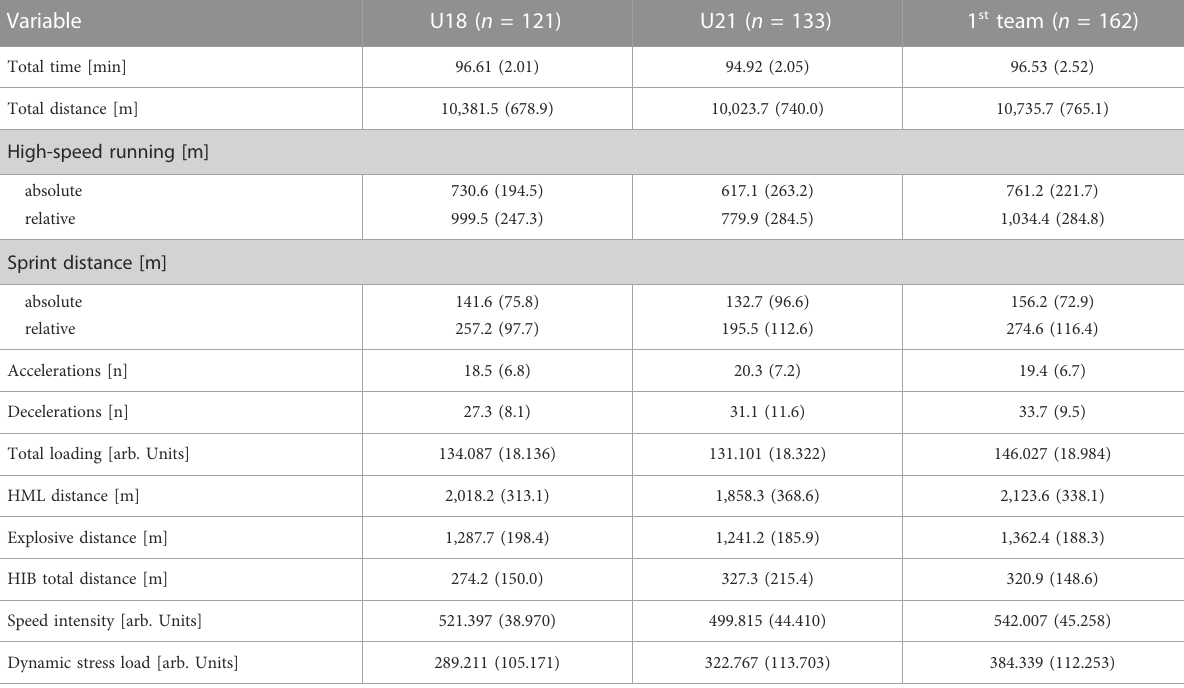
TABLE 7 Summary of the U18, U21, and fi rst teams ’ match loads. Data presented as mean (SD).